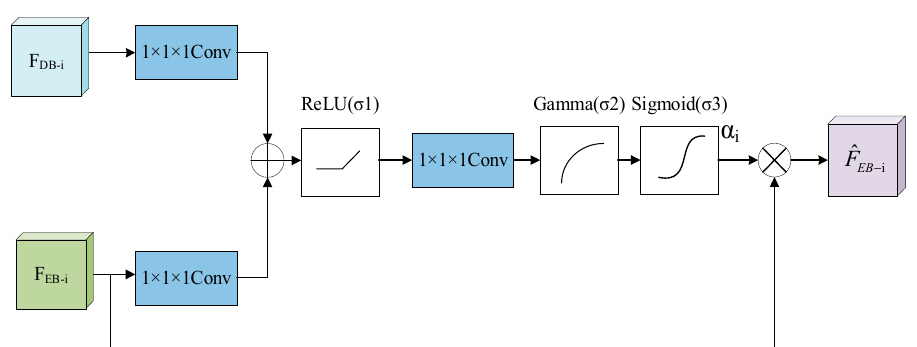
Figure 5. The detailed structure of multi-scale attention mechanism.